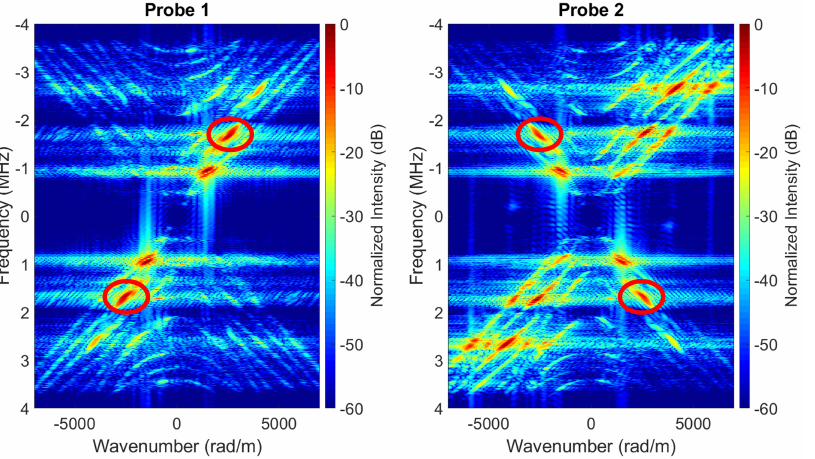
Figure 9. 2D Fourier transform of the spatio-temporal data shown in Figure 8b. The red circles frame the bandwidth of energy associated to the wave mode of interest. All other bandwidths of energy are associated to spurious wave